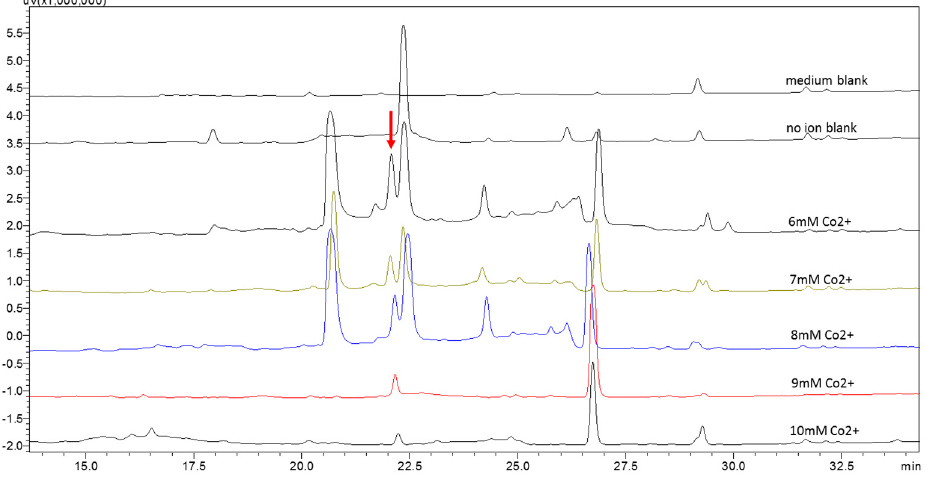
Figure 2. Metabolic profile of strain WU 243 by HPLC analysis: blank control and six sets of different ion concentrations.